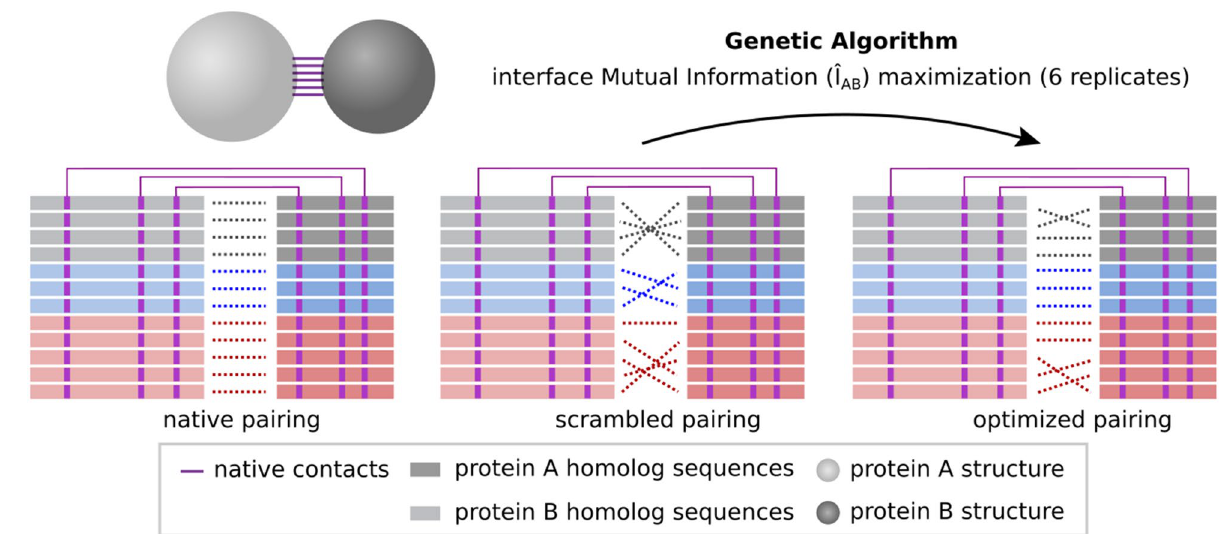
Figure 8. Scheme showing interface mutual information ( ˆ I AB ) optimization process for the HK-RR standard dataset. It starts from a within-species scrambled MSA concatenation and reaches an optimized concatenation. Different species are shown in different colors. Only physically coupled MSA position pairs (shown in purple) are taken into account and only within-species changes are made in each generation. This figure was created with Inkscape (https:// inksc ape.